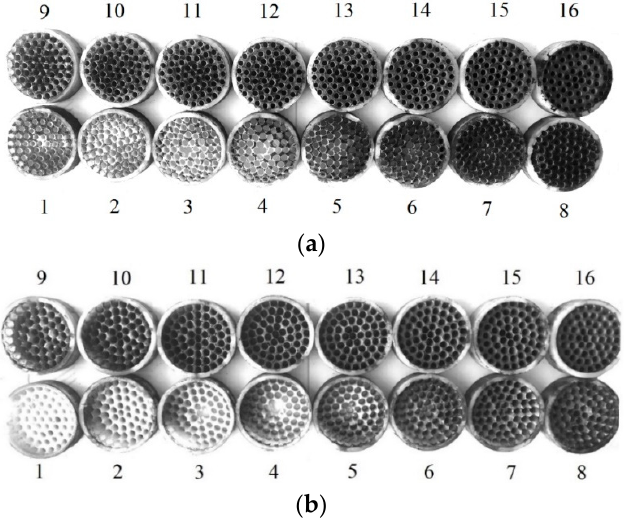
Figure 13. Photographs of ( a ) upstream and ( b ) downstream faces of blocks composing LSM sample after test 3 with combustion.